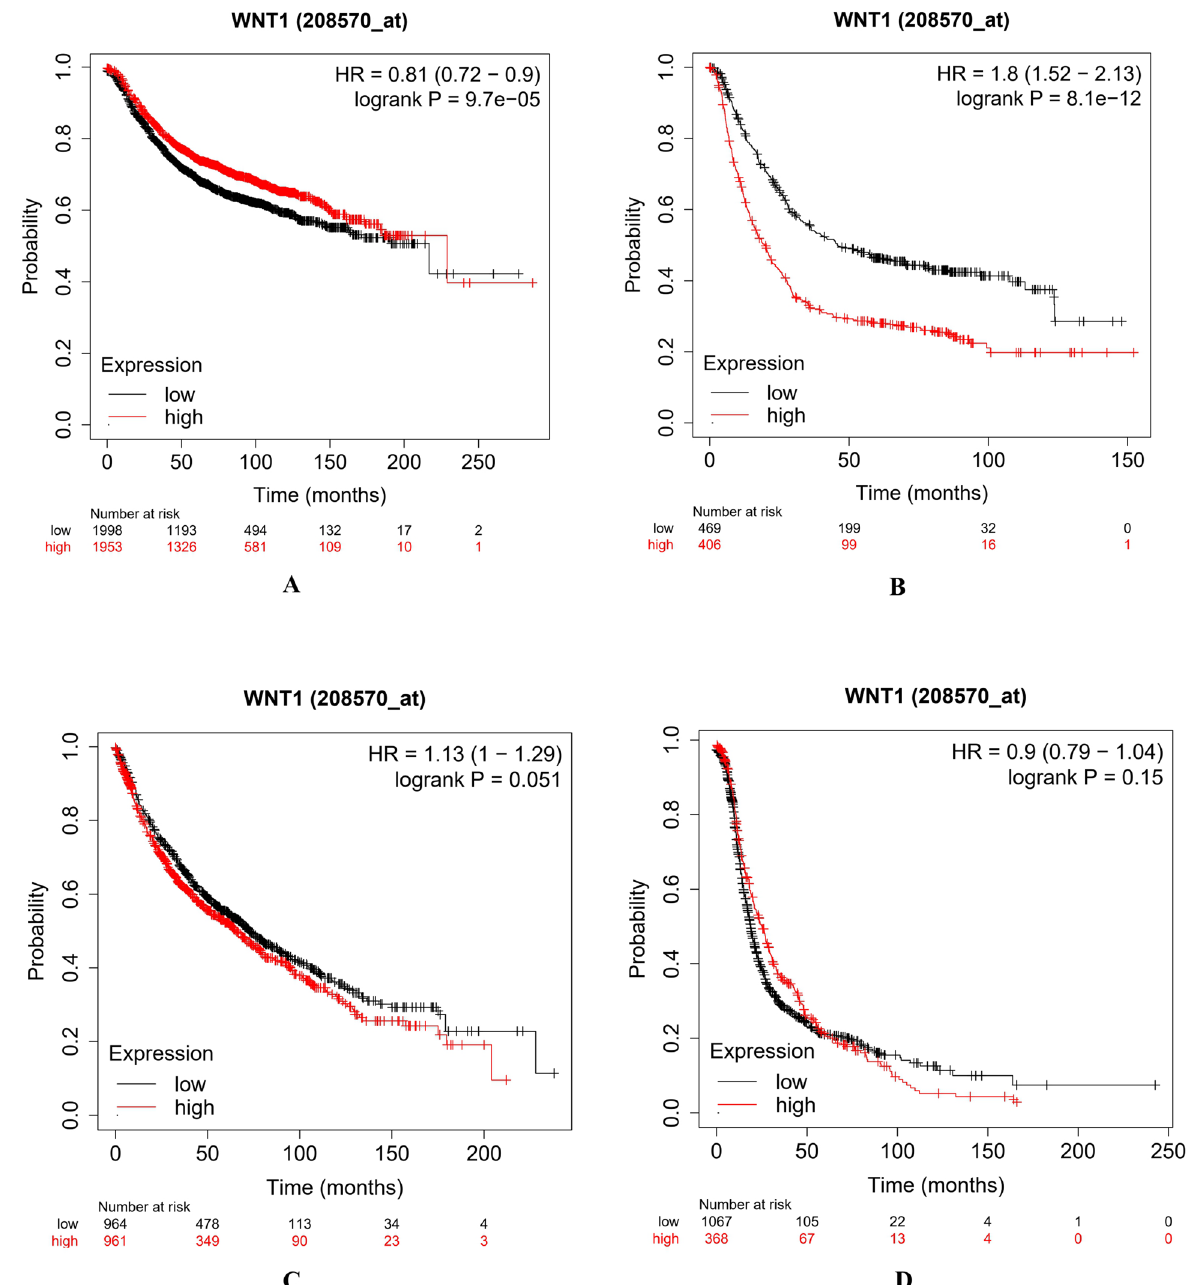
Figure 6. Deregulation of Wnt1 gene expression and overall survival of patients with breast ( A ), gastric ( B ), lung ( C ) and ovarian ( D ) cancer, using microarray gene expression profile by